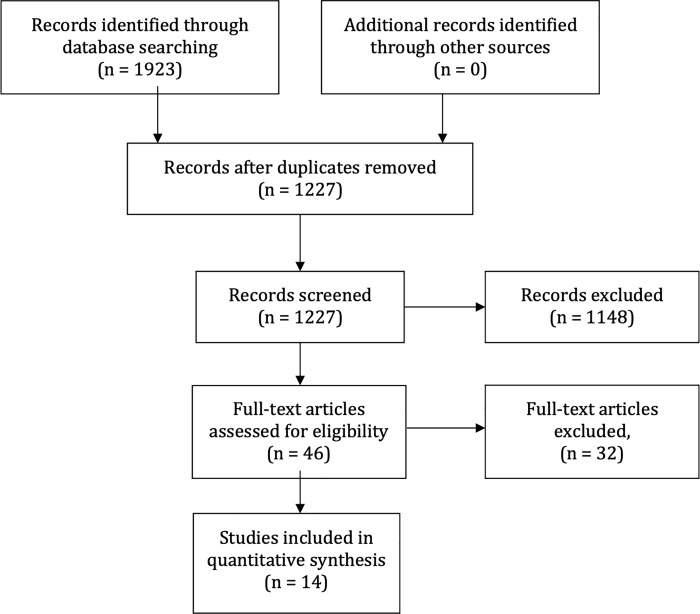
PRISMA flow diagram.